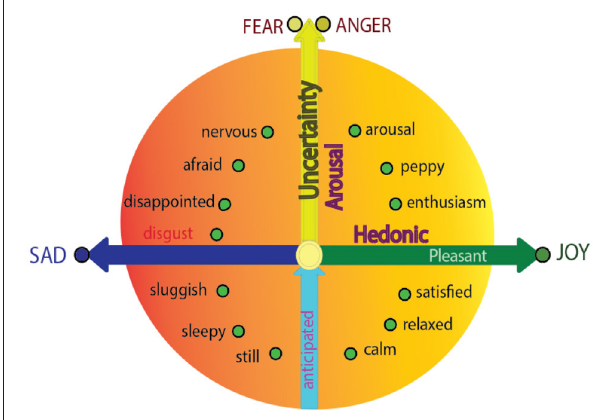
FIGURE 1 | Integrative approach for emotional dimensions and basic emotions. The integrative approach for Basic emotion theory and dimensional theory proposes that the reason that “basic emotions” are “basic” is that the basic emotions are located on the axis of the circumplex ( Posner et al., 2009). It means that each “basic emotion” is a special emotion that represents one feature of emotion as a whole, named core affect (arousal or hedonic value) (Wilson-Mendenhall et al., 2013): fear and anger represent the arousal value; while sadness and joy represent the hedonic value, which is related to the hedonic values of the stimulus. Put it another way, “pure” fear and anger are not related to hedonic values; “pure” sad and joy are not related to safety values (modified from previous publications). Please refer to Gu et al.